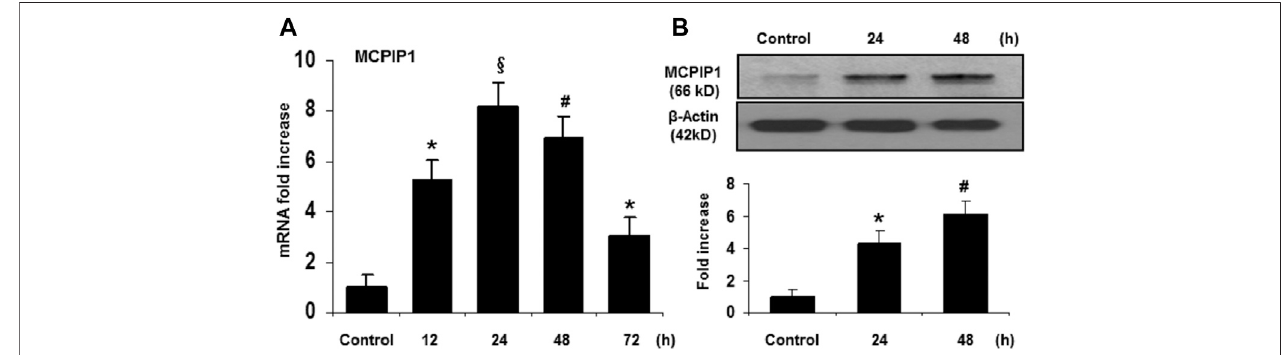
FIGURE 1 | TMP upregulates MCPIP1 expression in the murine brain. The C57BL/6 mice were treated with TMP 25 mg/kg or vehicle administered intraperitoneally,andexpressionofMCPIP1wasmeasuredat12,24,48,and72 hafterTMPadministration. (A) mRNAlevelsforMCPIP1inthemousebraincortexwere measured by qRT-PCR, and expressed as fold changes of untreated controls. * p < 0.05, # p < 0.01, § p < 0.001 versus untreated controls; n (cid:1) 5 per timepoints. (B) Protein levels for MCPIP1 in mouse brain were measured by immunoblots ( Upper panel ) , and the immunoreactivity bands were quanti fi ed by densitometry analysisnormalizedto β -actin, and expressed asfoldchangesovertheuntreated controls ( Lower panel ) .* p < 0.05, # p < 0.01, § p < 0.001versusuntreatedcontrol.n (cid:1) 5 per timepoints.